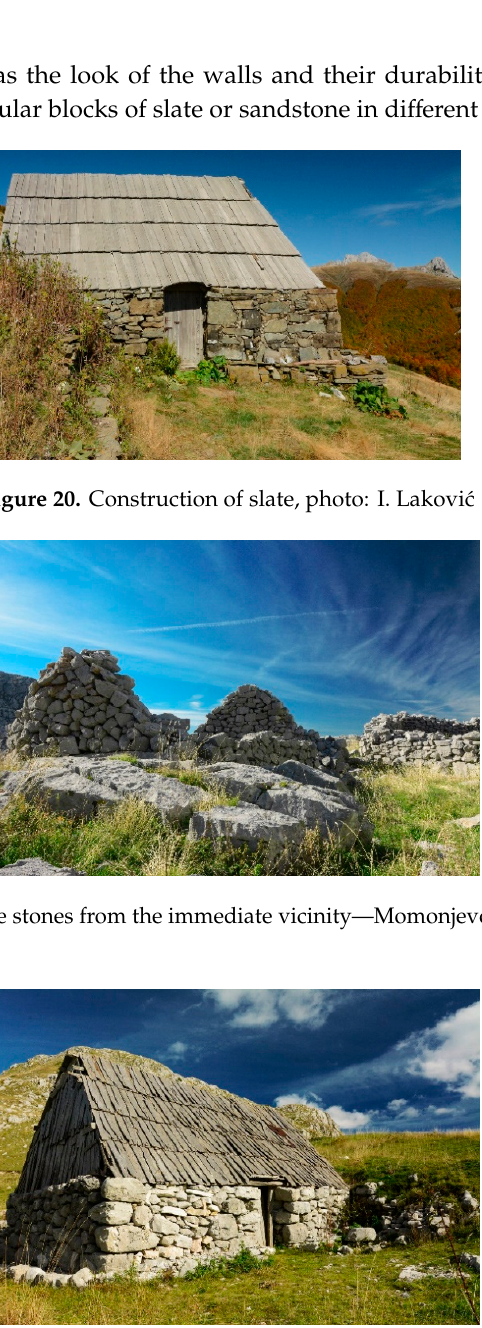
Figure 22. Glada with larger and better-dressed blocks - Upper Rikavac, the katun of Du č i ć i, photo: I. Lakovi ć .